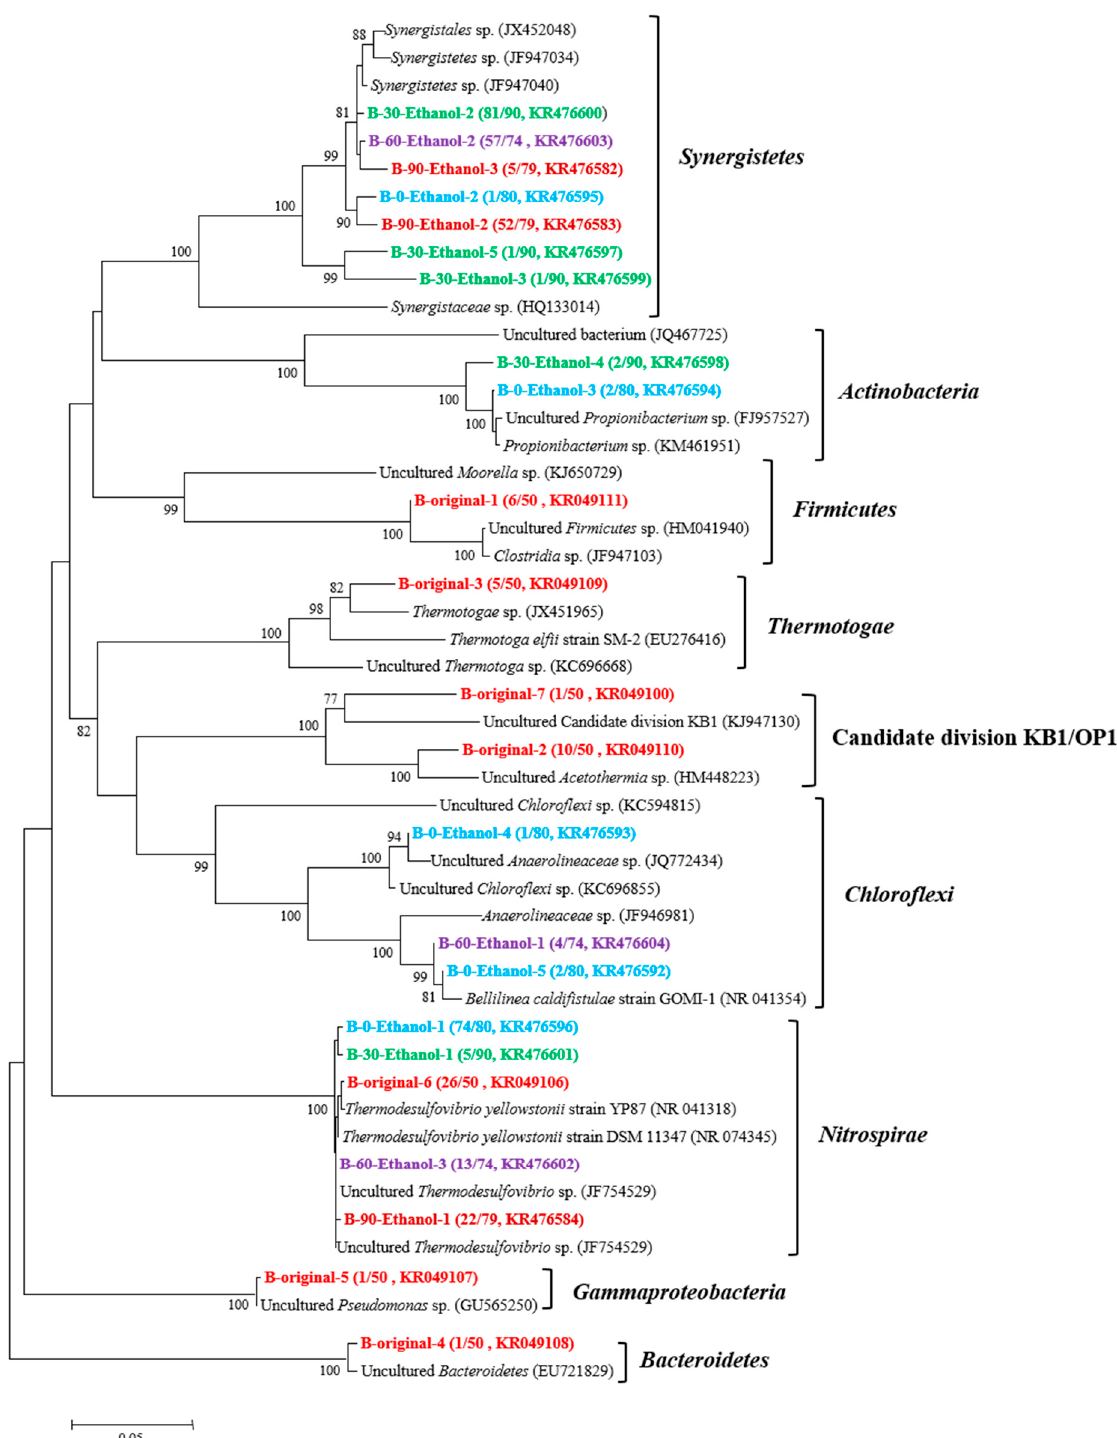
Figure 3. Phylogenetic tree of the 16S rRNA gene sequences of bacteria from different enrichment cultures after anaerobic incubation (indicated by different colors) revealed by the clone libraries. Scale bars show five (0.05) nucleotide substitutions per 100 nucleotide base pairs. The number in parentheses is the number of